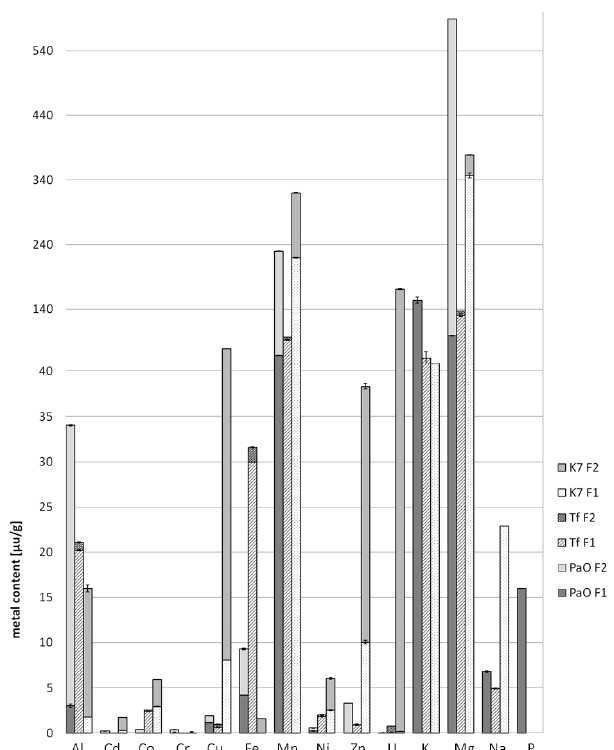
Fig. 2. Available metals and micronutrients [µgg − 1 soil] of mobile fraction (F1) and specifically adsorbed fraction (F2) from